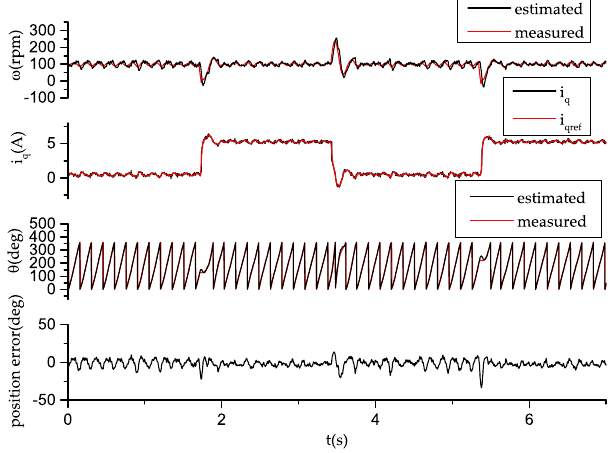
Figure 18. Experimental results of sensorless operation with step load disturbance.